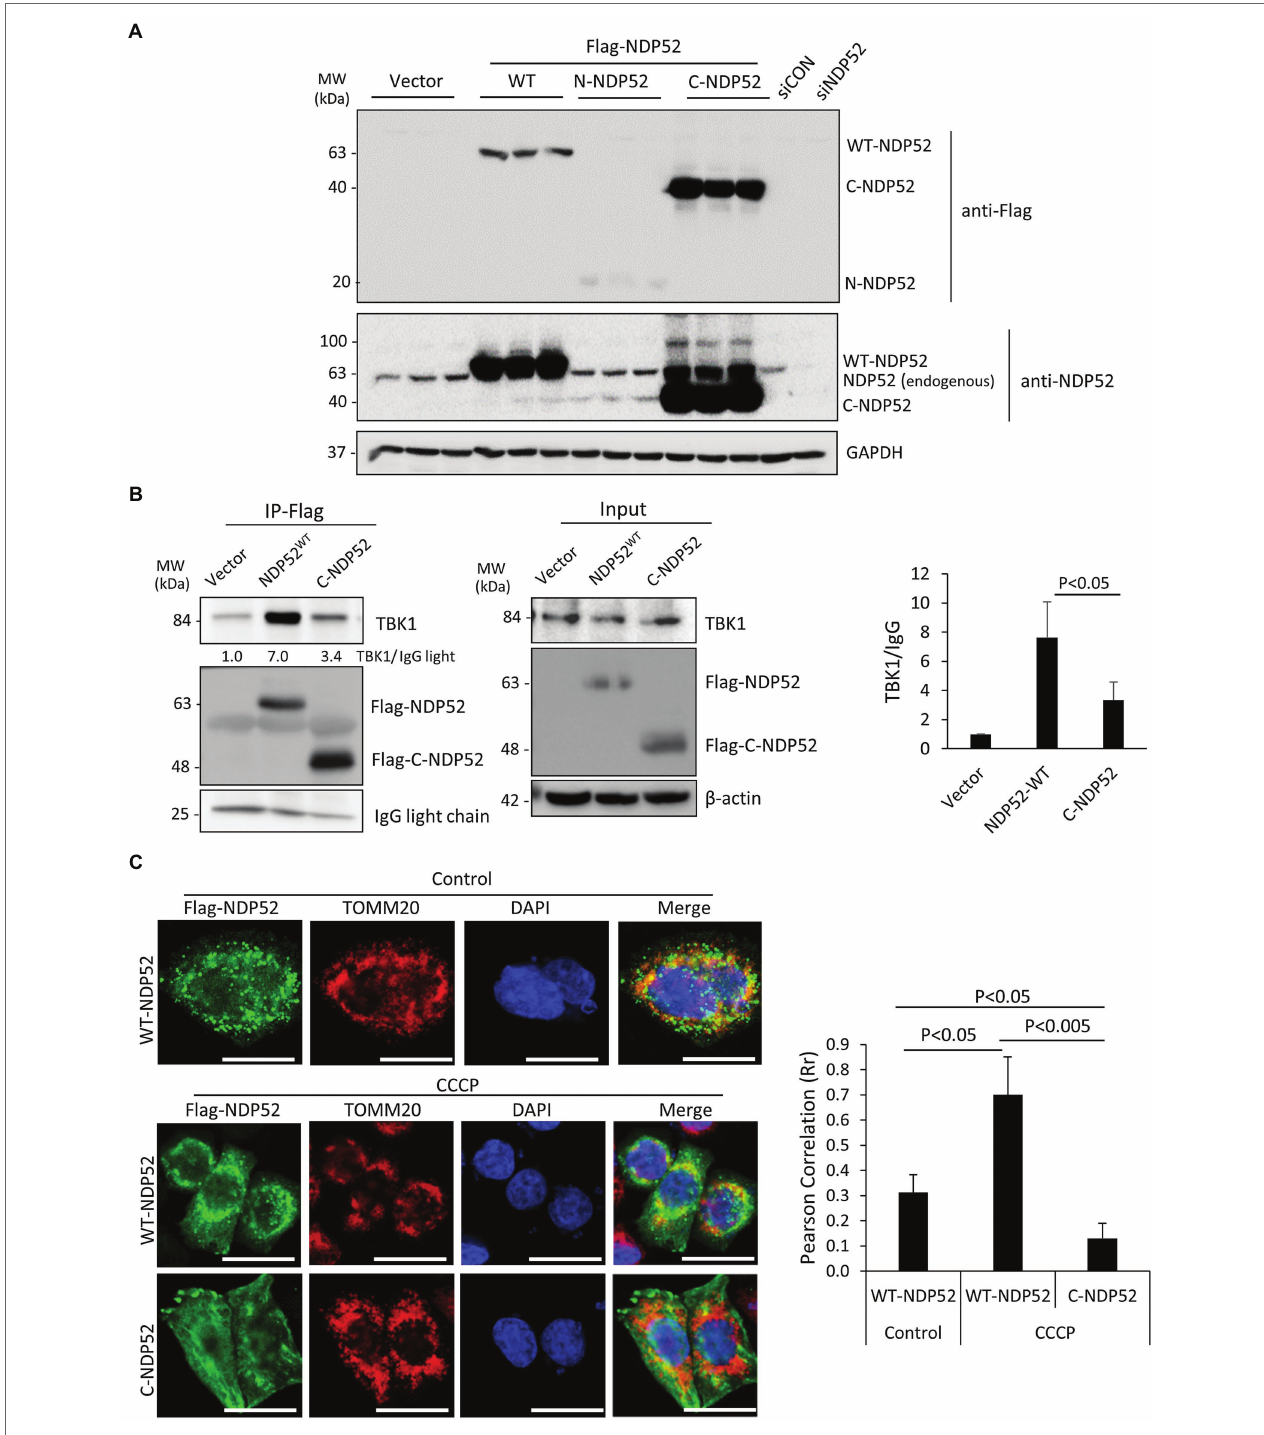
FIGURE 6 | The C-terminal NDP52 cleavage fragment shows the reduced TBK1 binding affinity and impaired mitochondrial localization. (A) HeLa cells were transfected with various Flag-tagged NDP52 constructs as indicated for 24 h. Cell lysates were analyzed by Western blotting with anti-Flag and anti-NDP52 antibodies. (B) HeLa cells were transfected with empty vector, Flag-NDP52 wt , or Flag-C-NDP52 for 24 h. Cell lysates were subjected to immunoprecipitation with anti-Flag antibody and analyzed by Western blotting. The amount of TBK1 pull-down was normalized to anti-Flag IgG light chain and presented in the bar plot (mean ± SD, n = 3 independent experiments). (C) HeLa cells were transfected with either Flag-NDP52 wt or Flag-C-NDP52 for 24 h. Cells were then treated with either vehicle or CCCP (10 μ m) for 6 h, followed by immunostaining with anti-Flag (green) for NDP52 and anti-TOMM20 (red) for mitochondria. Co-localization was assessed using NIH ImageJ software and presented as Pearson’s correlation (Rr ± SD, n > 30 cells) in the right panel. Scale bar = 20 μ